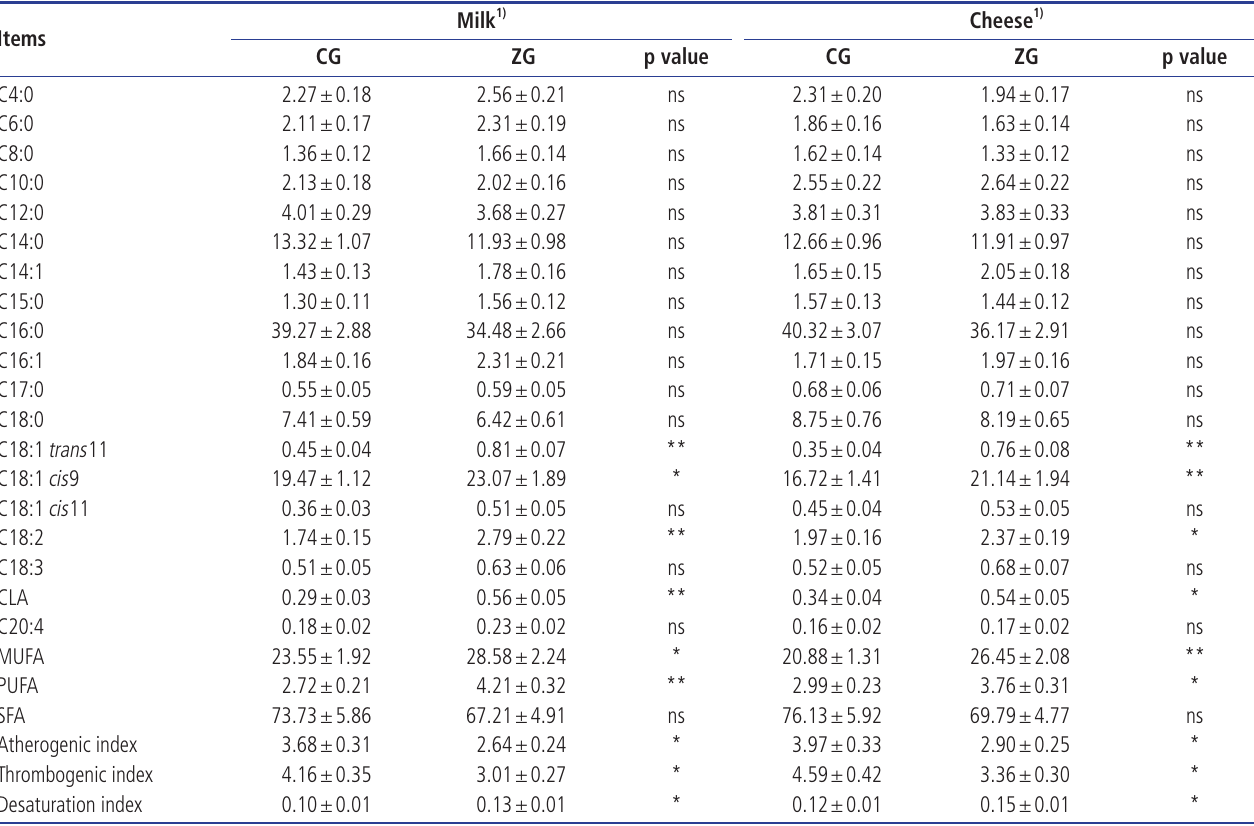
Table 4. Fatty acid profile of bulk milk and related cheeses obtained from the control and the experimental group Milk 1) Cheese 1) Items